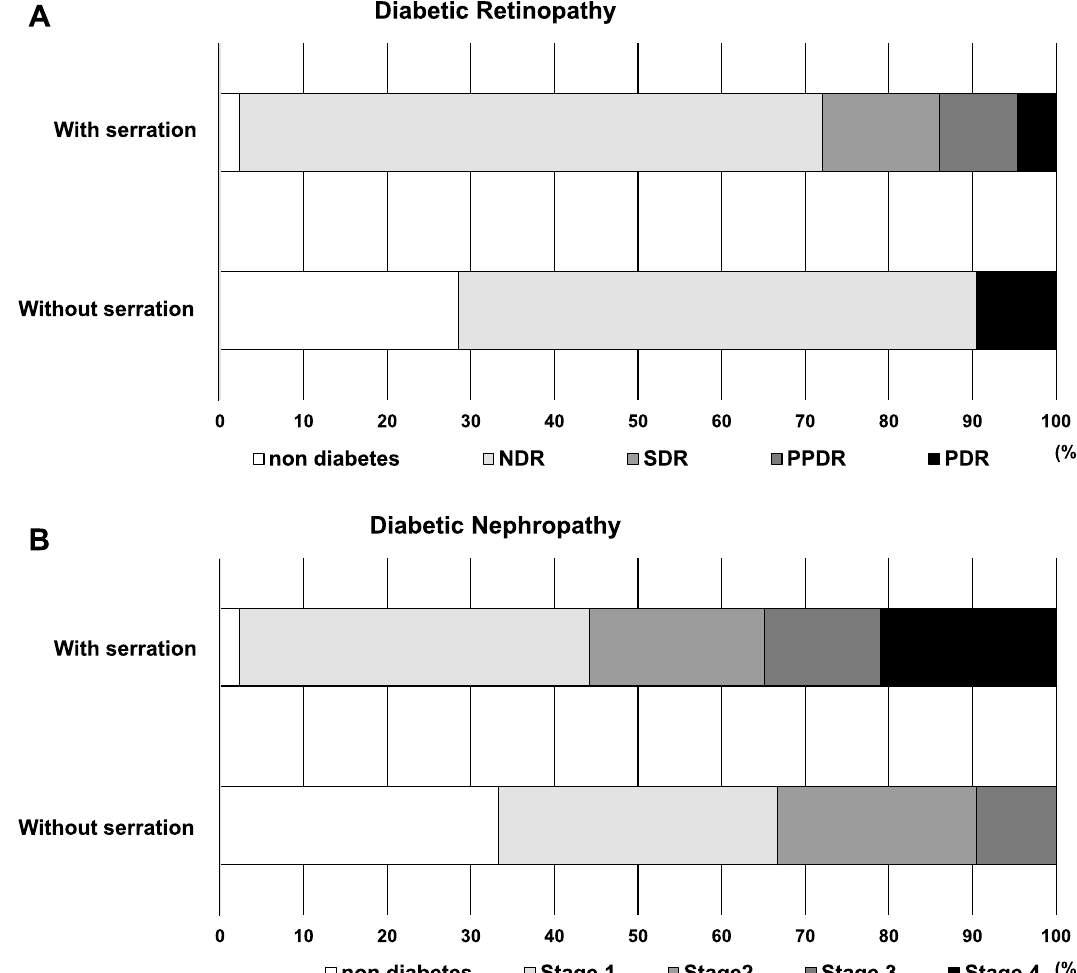
Figure 3. Possible association between the serrated pancreas and microvascular complications. Advanced diabetic retinopathy and nephropathy were more often observed in subjects with serrated changes compared to those without them ( p < 0.05, p <